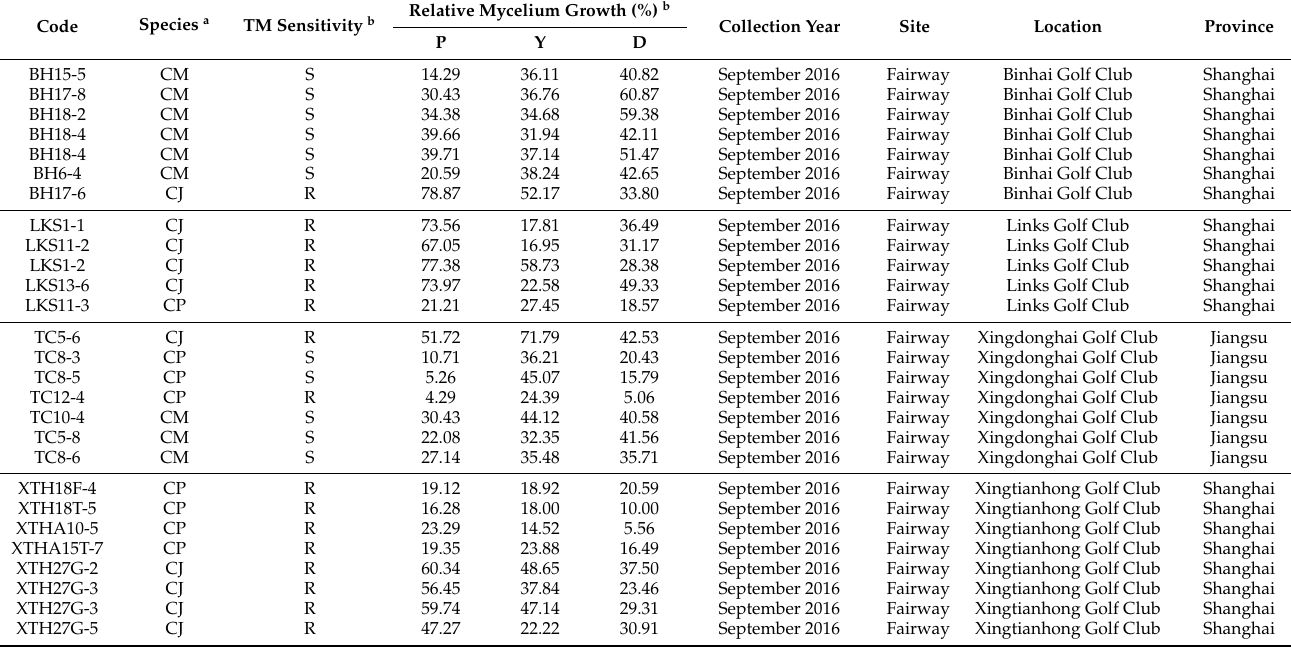
Table 3. Fungicide sensitivity in Clarireedia isolates from Paspalum vaginatum in the four locales with at least two species coexistence.